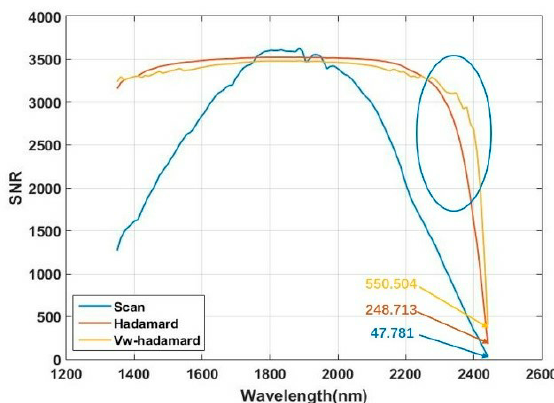
Figure 13. SNR of the spectrometer with the order of 107.